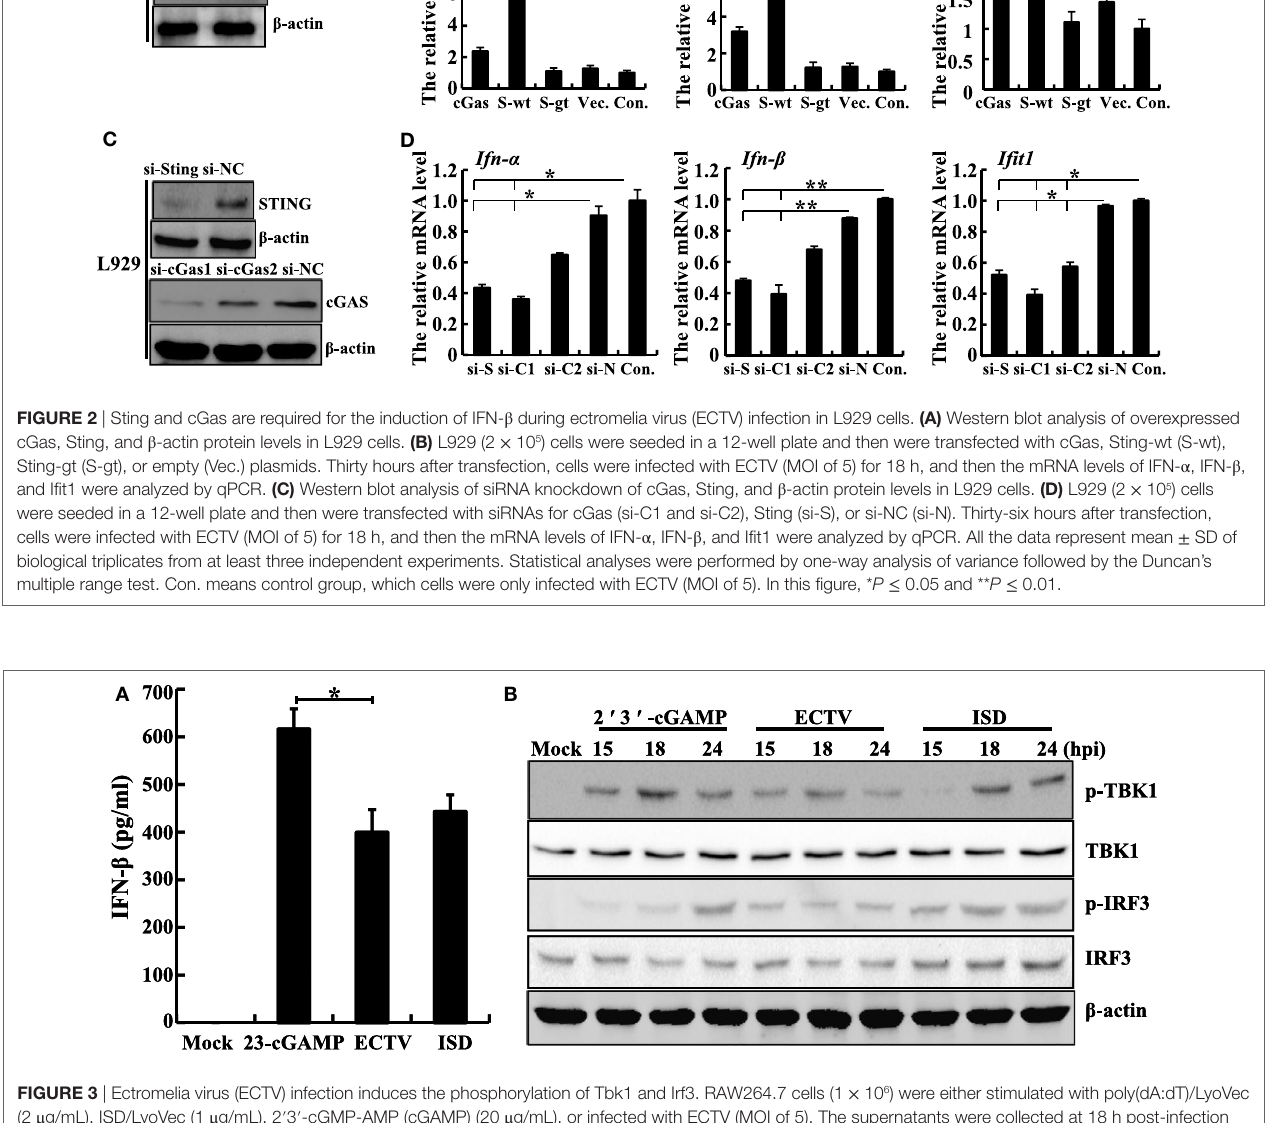
FigUre 3 | Ectromelia virus (ECTV) infection induces the phosphorylation of Tbk1 and Irf3. RAW264.7 cells (1 × 10 6 ) were either stimulated with poly(dA:dT)/LyoVec (2 μ g/mL), ISD/LyoVec (1 μ g/mL), 2 ′ 3 ′ -cGMP-AMP (cGAMP) (20 μ g/mL), or infected with ECTV (MOI of 5). The supernatants were collected at 18 h post-infection (hpi) for determining the concentrations of IFN- β by using enzyme-linked immunosorbent assay (ELISA) (a) , and cells were collected at 15, 18, and 24 hpi. All the collected cells were used for western blot analysis using anti-phospho-Tbk1, anti-Tbk1, anti-phospho-Irf3, and anti-Irf3 (B) . β -Actin was used as a loading control. The ELISA data were averaged from three independent experiments in biological triplicate. The data were analyzed using a one-way analysis of variance followed by the Duncan’s multiple range test. Results of western blot analysis shown are representative of three independent experiments (* P ≤ 0.05).